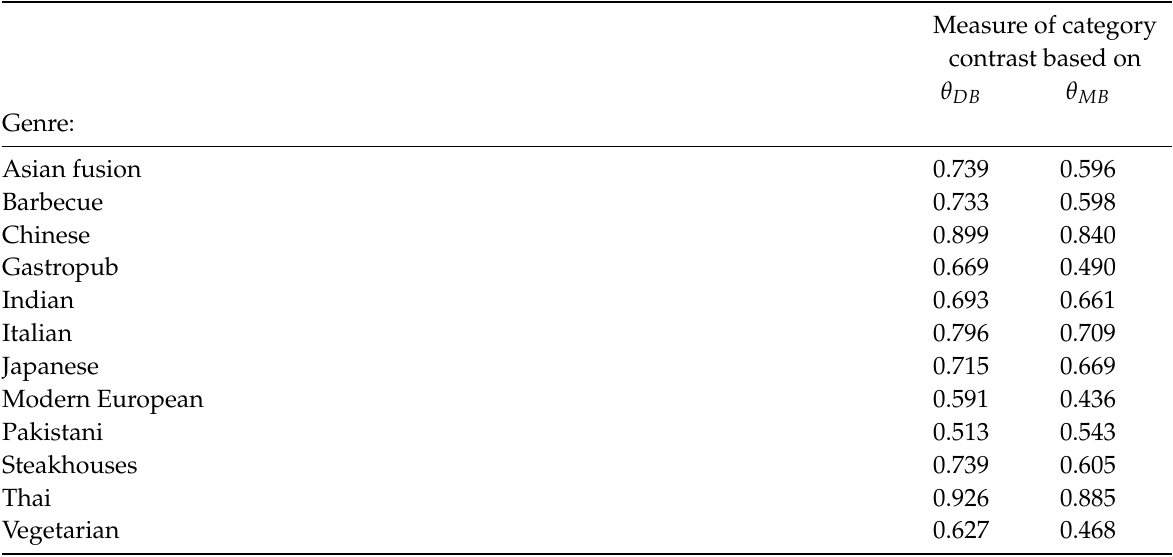
Table2: Contrasts of selected restaurant genres constructed using alternative measures of grade of membership: discrete/binary and the